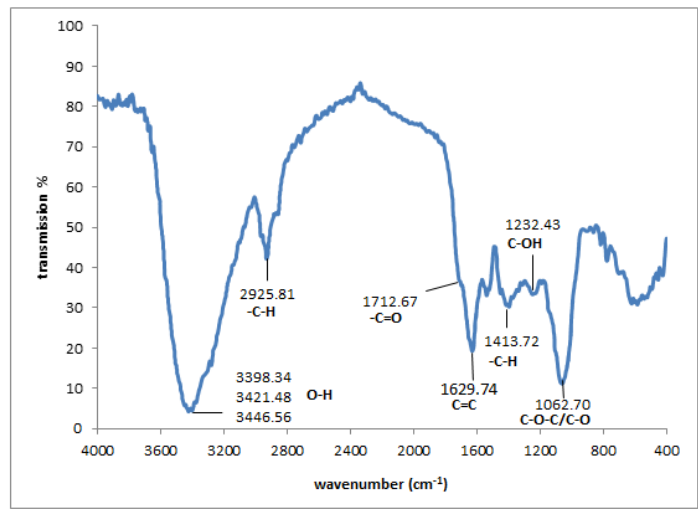
Fig.6: The FTIR spectrum of synthesized